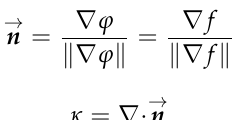
Figure 3. Two revolutions of a circle using a 50 × 50 structured mesh, where the nodes of active elements are included in the re-initialization step ( a ) An original circle before (dashed line) and after two revolutions (solid line). The normal vectors are shown after rotation, ( b ) The percentage of curvature deviation (solid line) and mass change (dashed line).